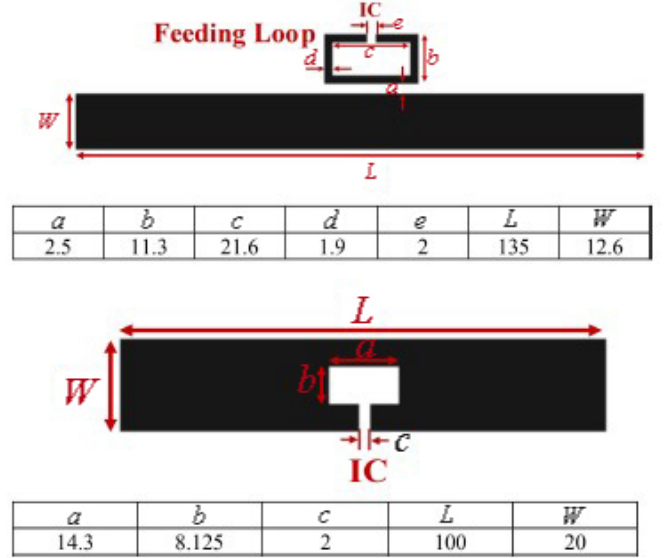
Figure 19. The layout of a chip-based antenna resonance controlled strain sensor [115].